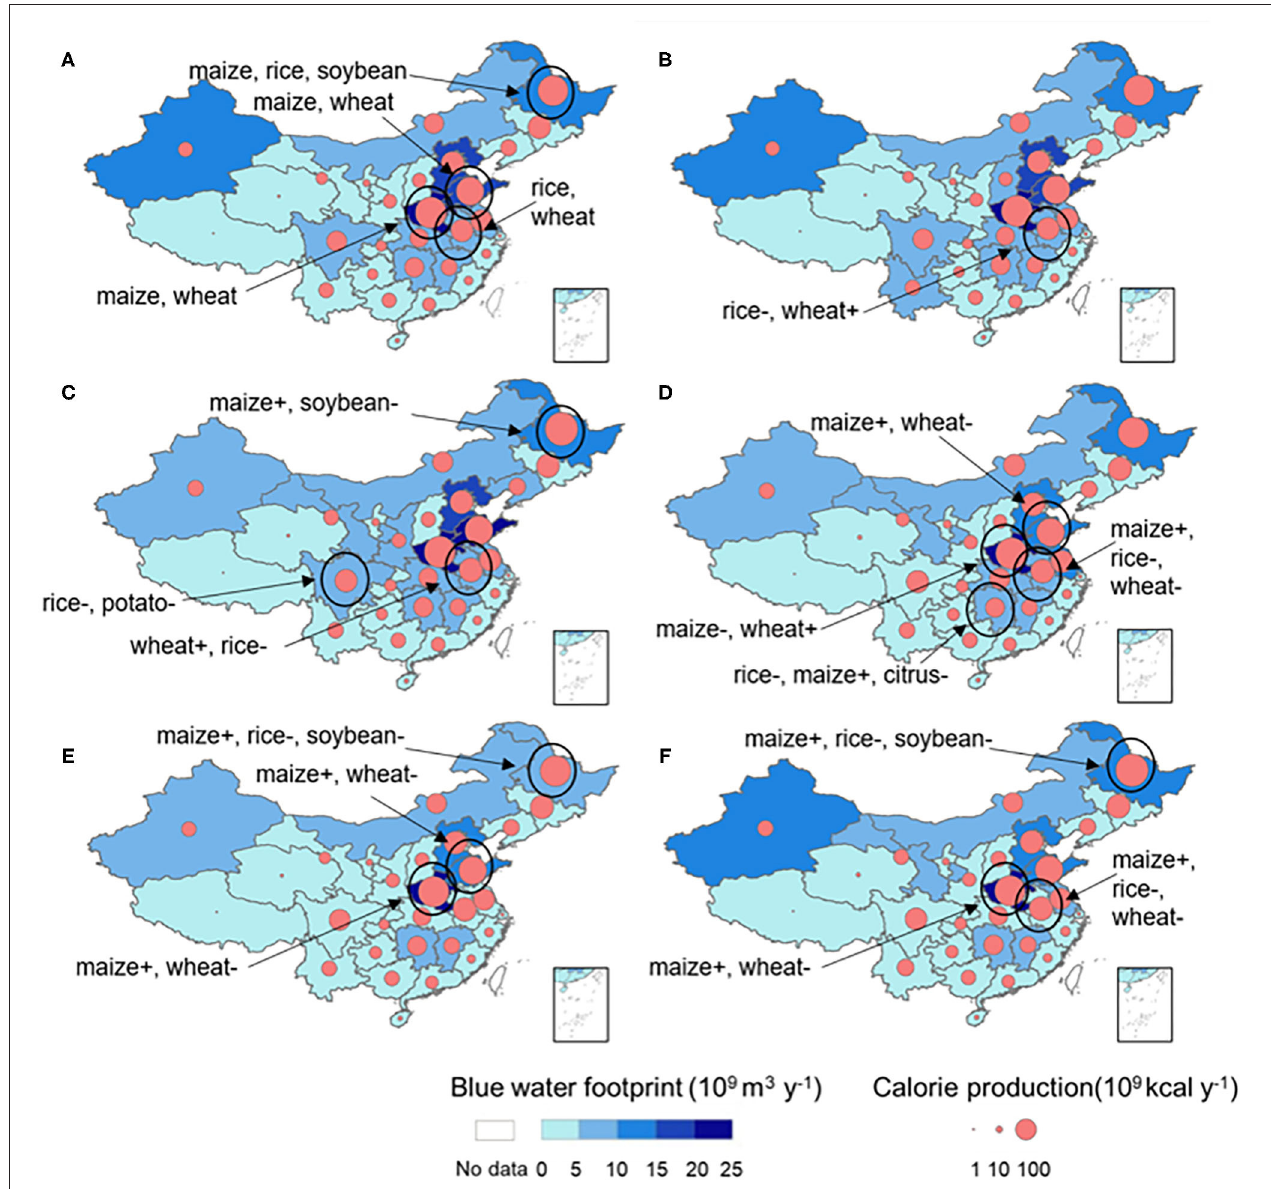
FIGURE 3 | Spatial distribution of BWF and CP in China under different crop production allocations. The six maps correspond to reference (A) , Rice - (B) , Potato - (C) , Citrus - (D) , Maize + (E) , and Maize ++ (F) . The darker the color of each region, the larger the BWF of crop production; the size of the pink circle represents the value of CP in each province. The regions with large adjustment of crop planting area are marked in the figure, and the texts indicate the increase ( + ) or decrease (–) state of corresponding crop planting